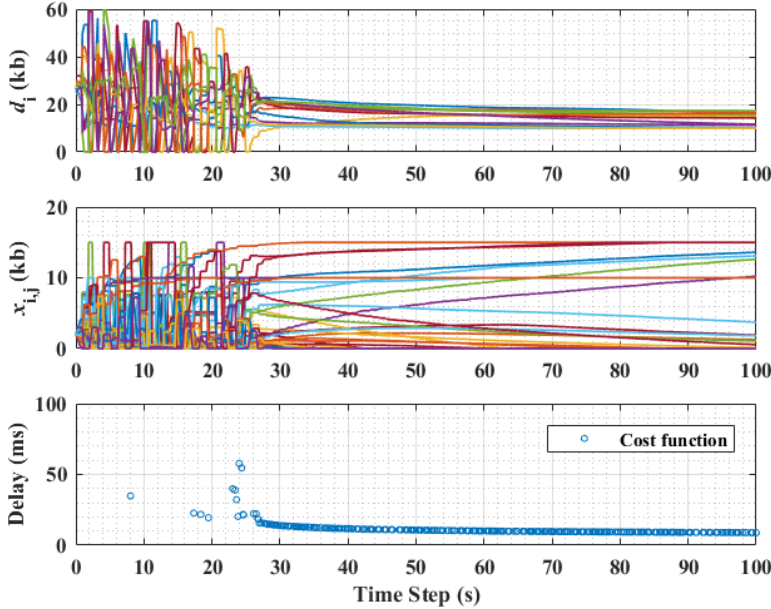
Figure 3. Full mesh topology: ( Topmost plot ) Convergence of the transmitted messages. ( Middle plot ) Convergence of the communication links. ( Lower plot ) The network delay